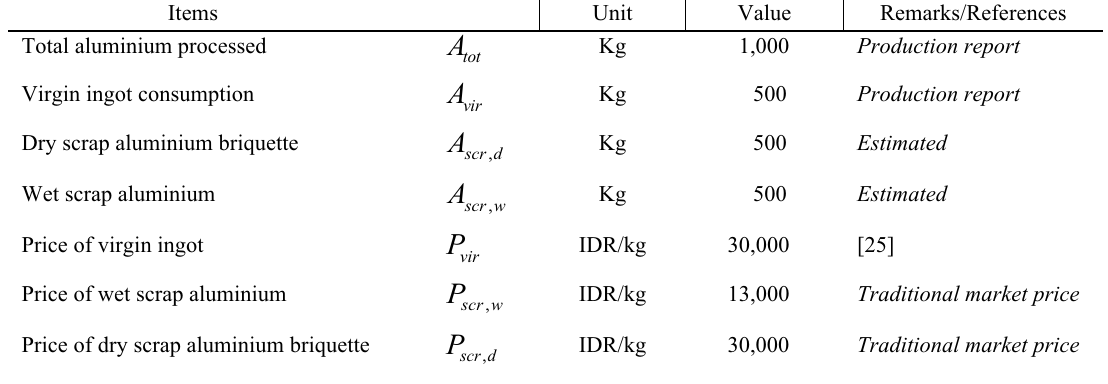
Table 1. Data for aluminium production